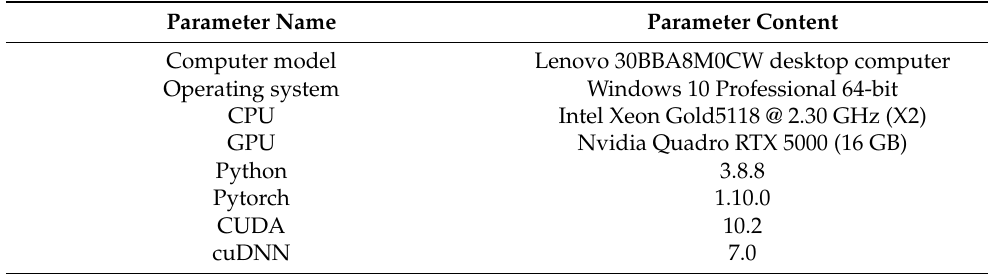
Table 1. Experimental hardware and environment settings.